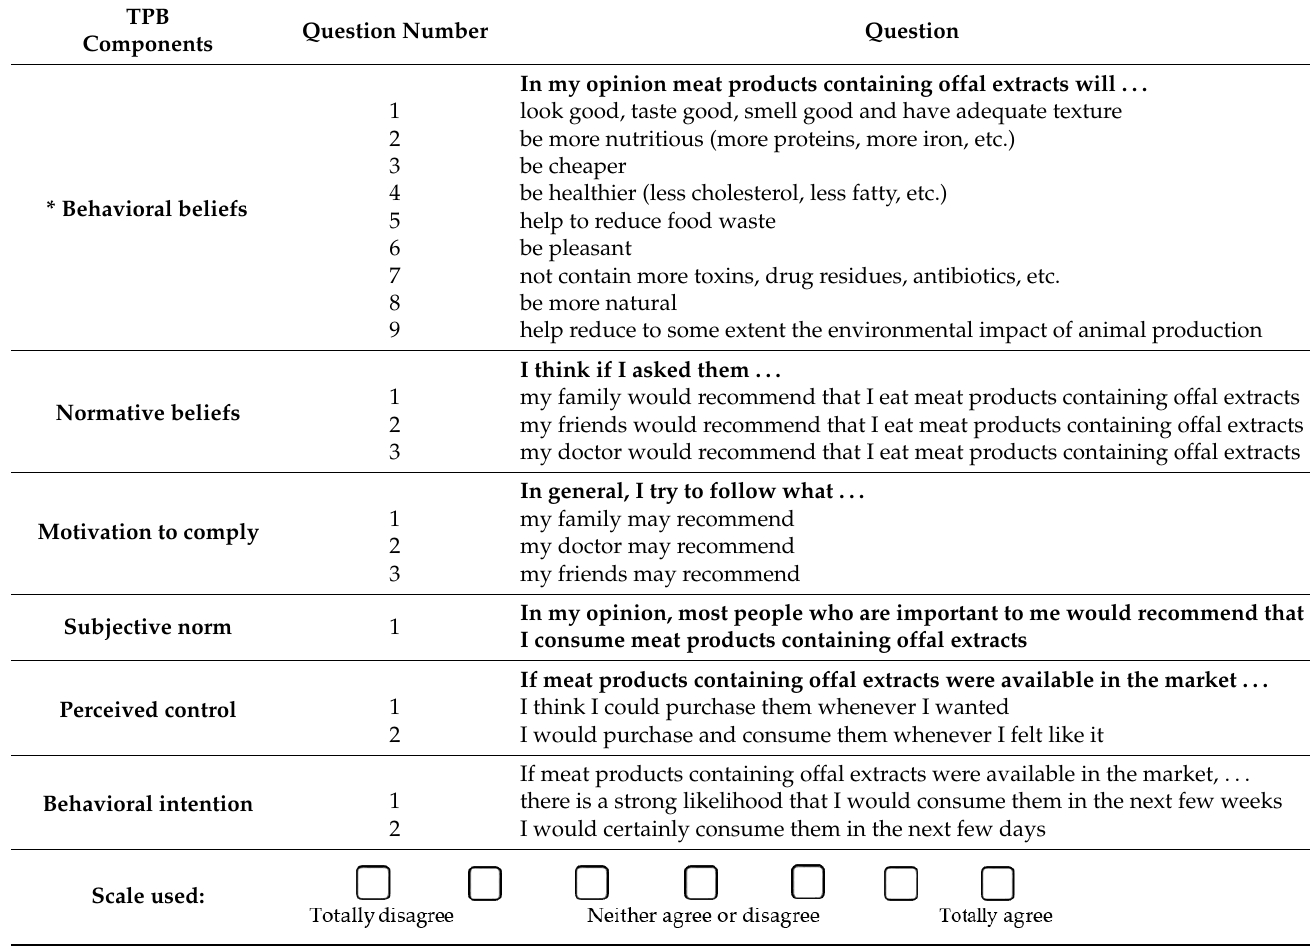
Table 1. Structure of the questionnaire.